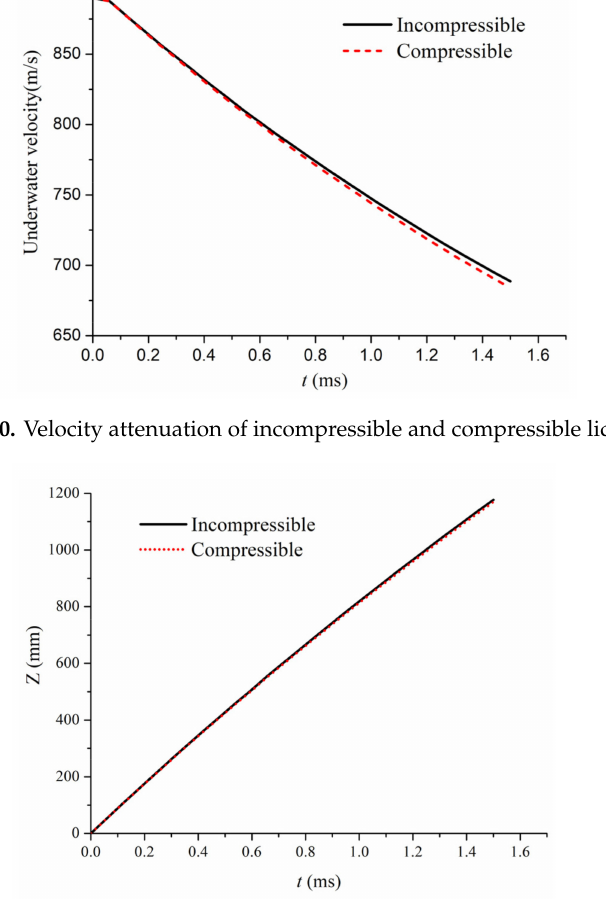
Figure 11. Trajectory along Z direction of incompressible and compressible